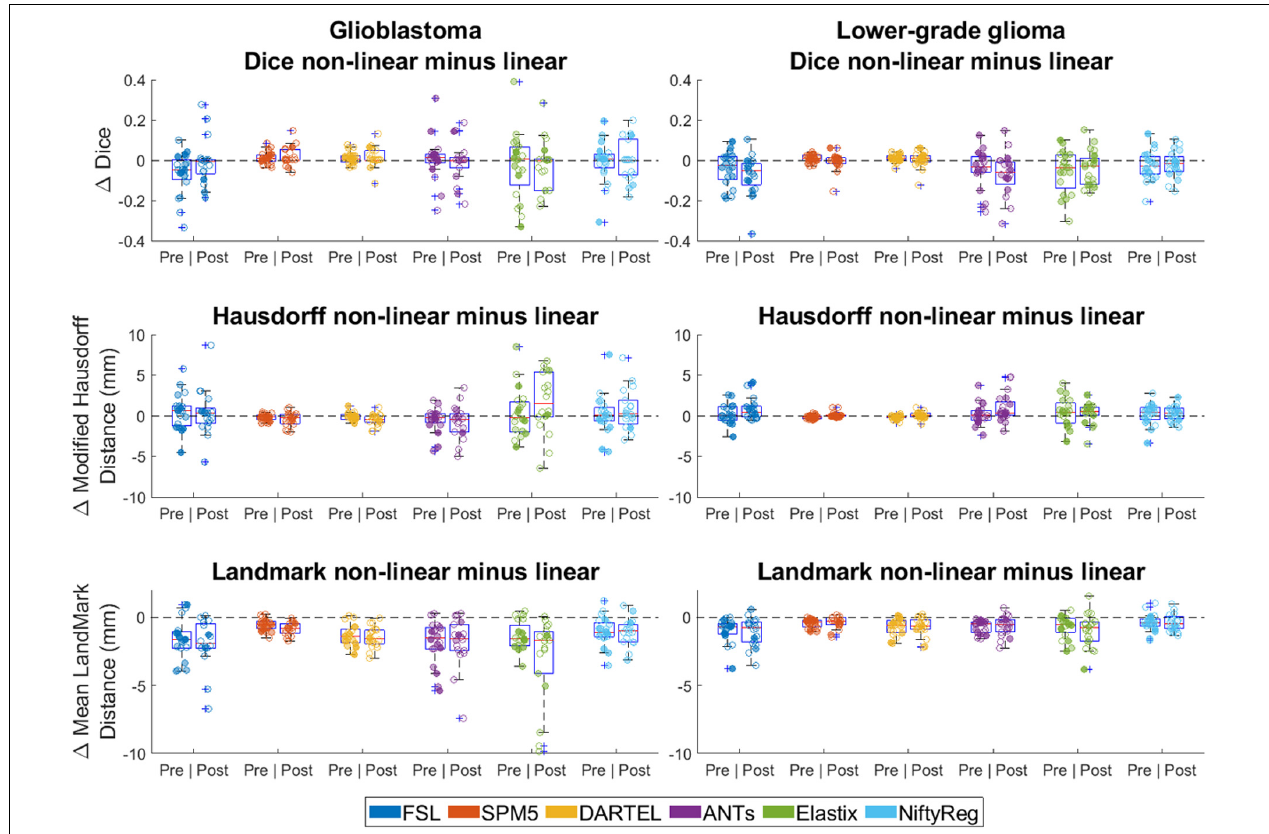
FIGURE 6 | Differences between linear and non-linear registration accuracy (non-linear minus linear). Left column shows differences in accuracy for glioblastoma, and the right column for lower-grade glioma. For Dice score positive difference values indicate better non-linear performance, for Hausdorff and mean landmark distance negative difference values indicate better non-linear performance. Each dot is a data point for an accuracy measure for a single patient. Dot transparency is controlled by the volume of the tumor connected to that data point divided by the maximum tumor volume in that distribution (more transparent is smaller relative volume). The whiskers extend to the most extreme data points not considered outliers, outliers are plotted individually using the ‘+’ symbol, boxes show the interquartile range, and the contained red line shows the median of each respective